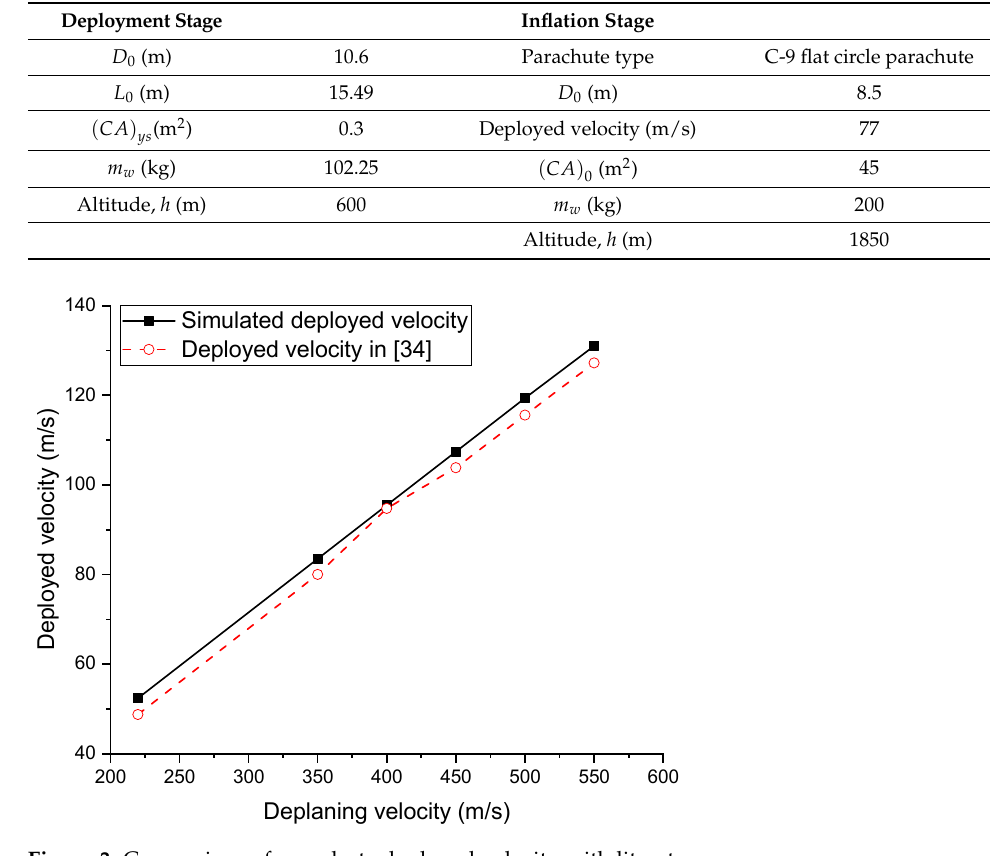
Table 1. Geometric and flight parameters of the parachute system.